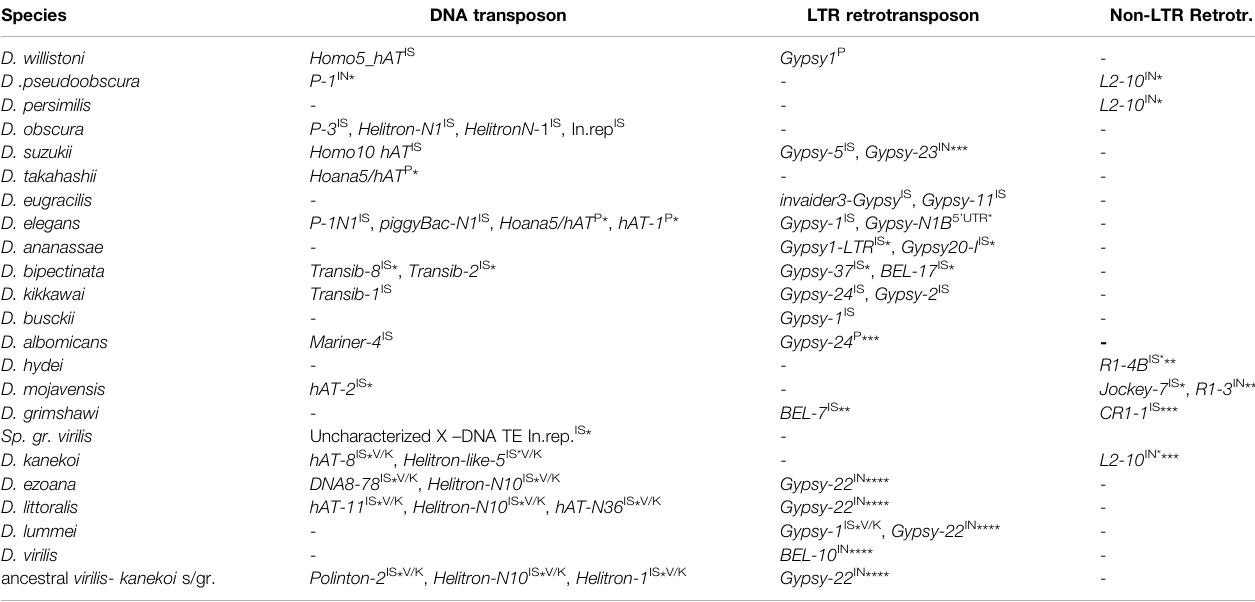
TABLE 2 | Homology with the transposon sequences of the ras85D noncoding and the upstream intergenic regions in Drosophila species. Species DNA